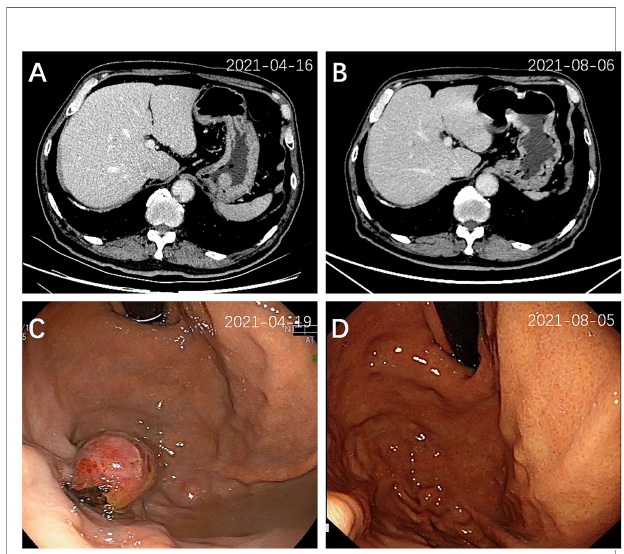
FIGURE 2 | Abdominal CT scan and endoscopic view of the gastric tumor at diagnosis (A, C) and 3 months after treatment (B, D) . A mass (2.0 cm × 2.0 cm) located in the gastric fundus was detected by CT (A) and gastroscopy (C) , which disappeared 3 months after treatment (B, D) .